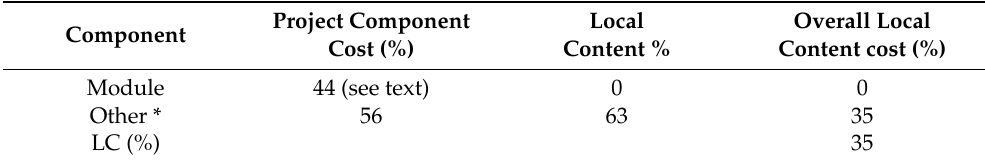
Table 2. MW Sakaka, PV farm in Saudi Arabia using International Energy Agency (IEA)